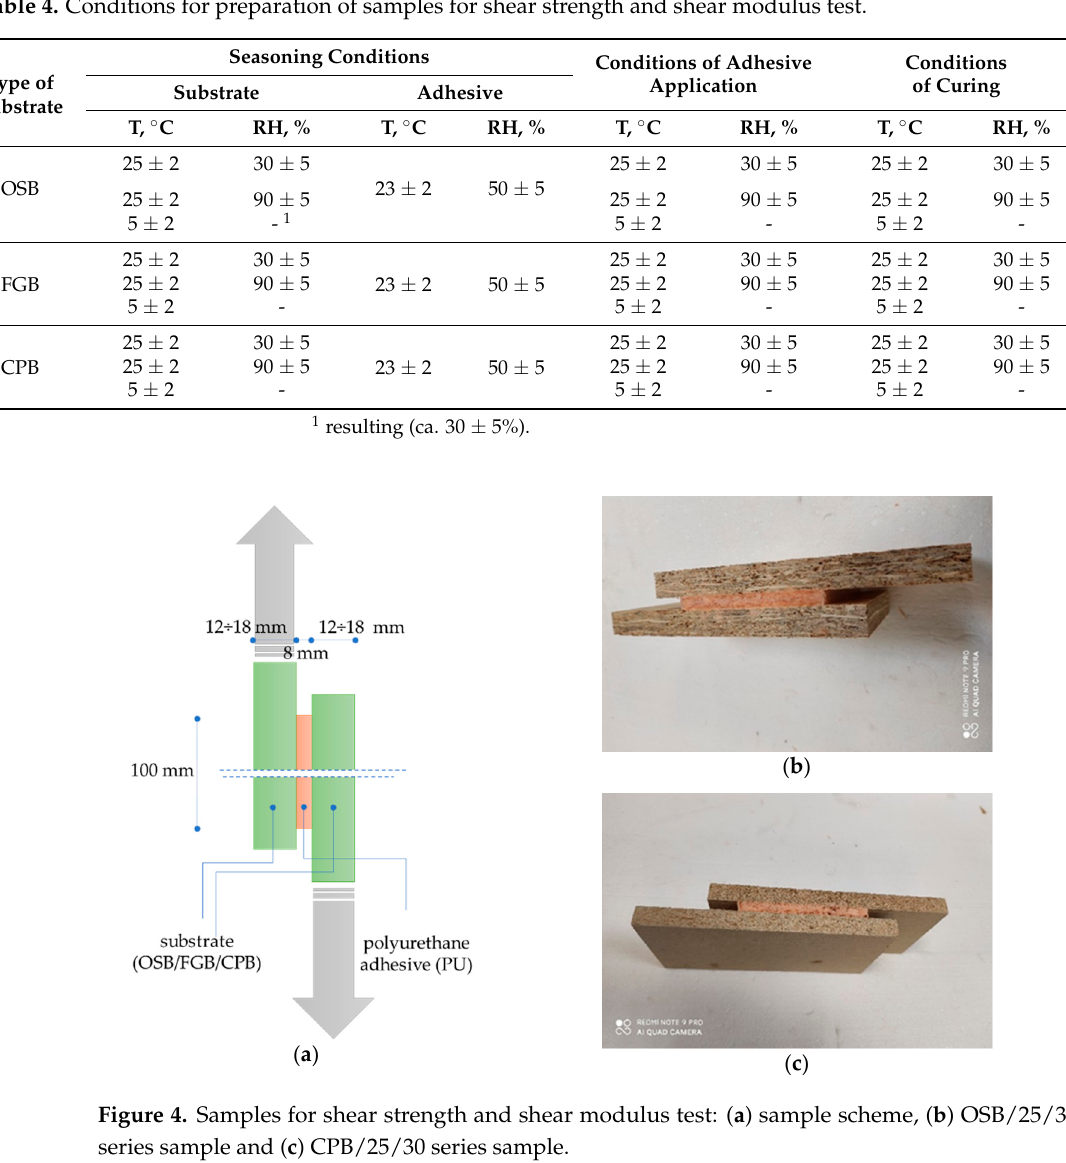
Table 4. Conditions for preparation of samples for shear strength and shear modulus test.